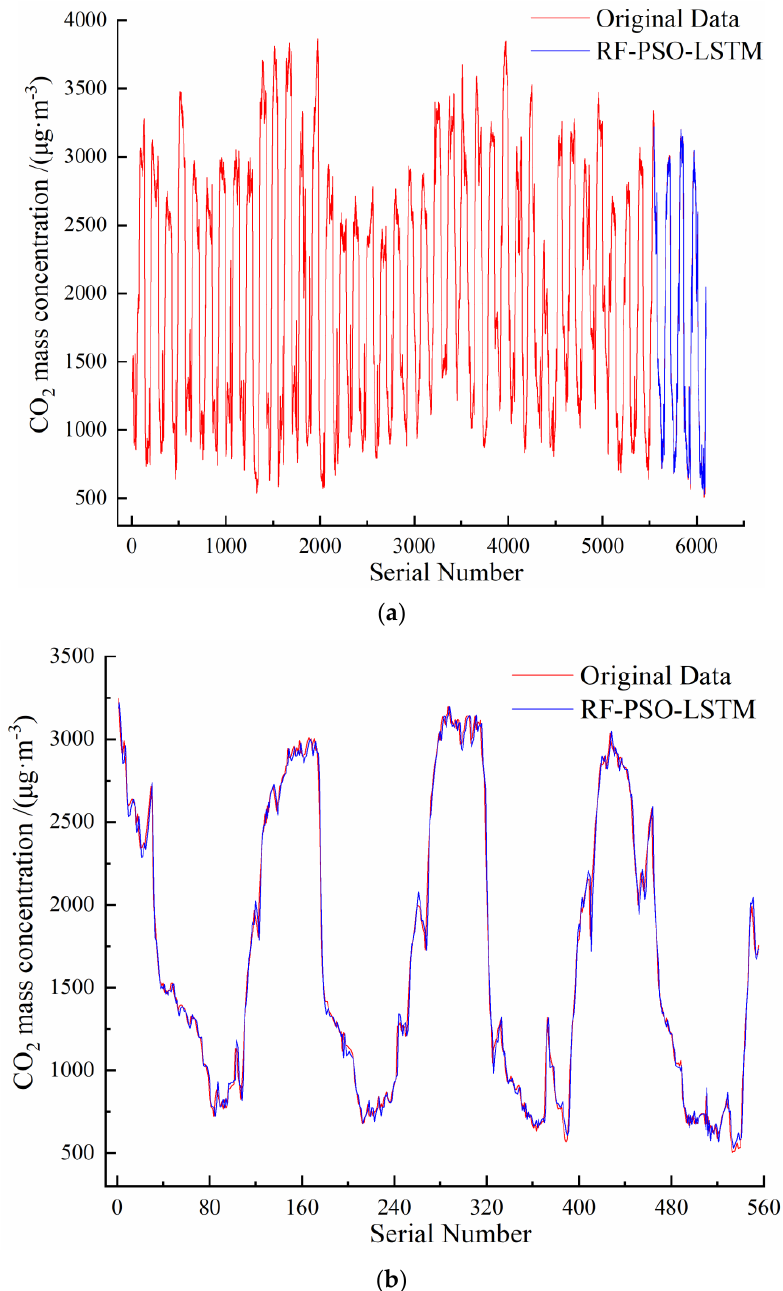
Figure 7. Prediction effect of RF-PSO-LSTM model: ( a ) overall forecast trend; ( b ) model prediction.